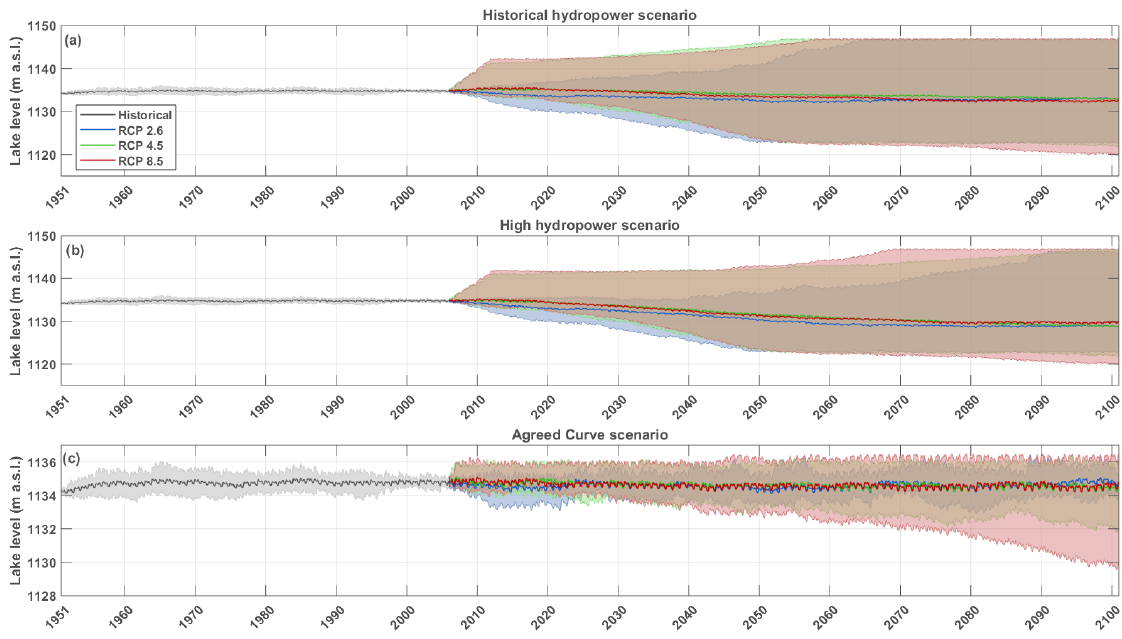
Figure E4. As in Fig. 8, but bias corrected using empirical quantiles.